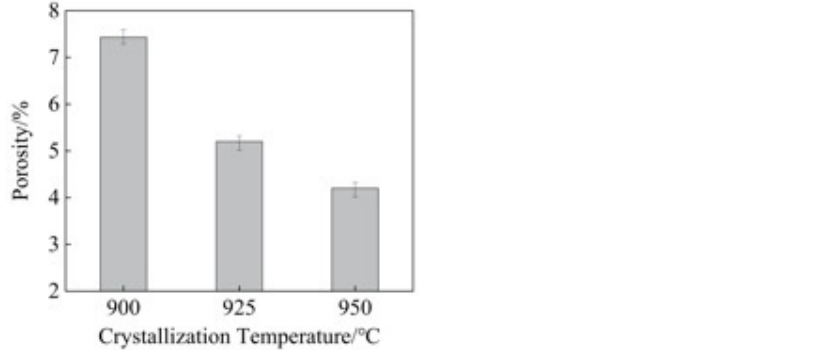
Figure 7. Effects of crystallization temperature on porosity of the microcrystalline glass.